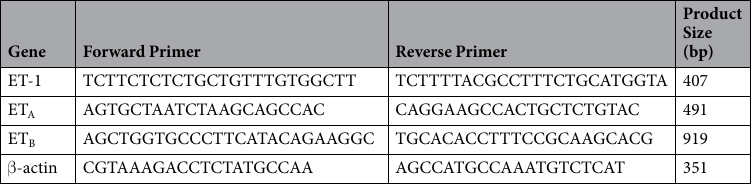
Table 1. Primer sequences for Real Time RT-PCR.